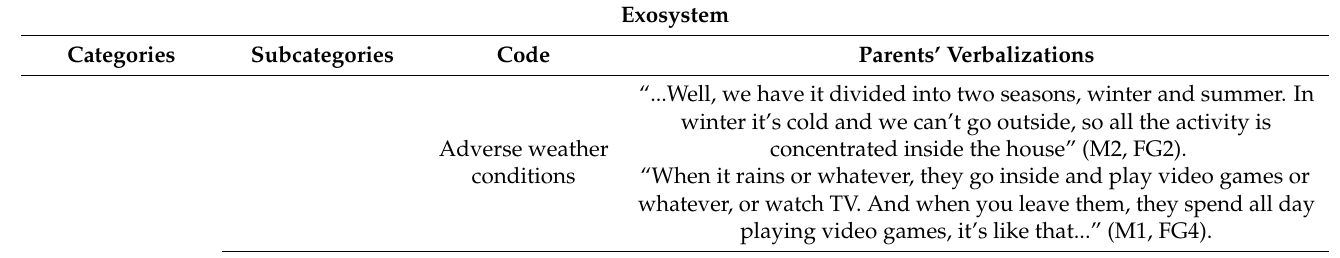
Table 6. Exosystem barriers to physical activity for